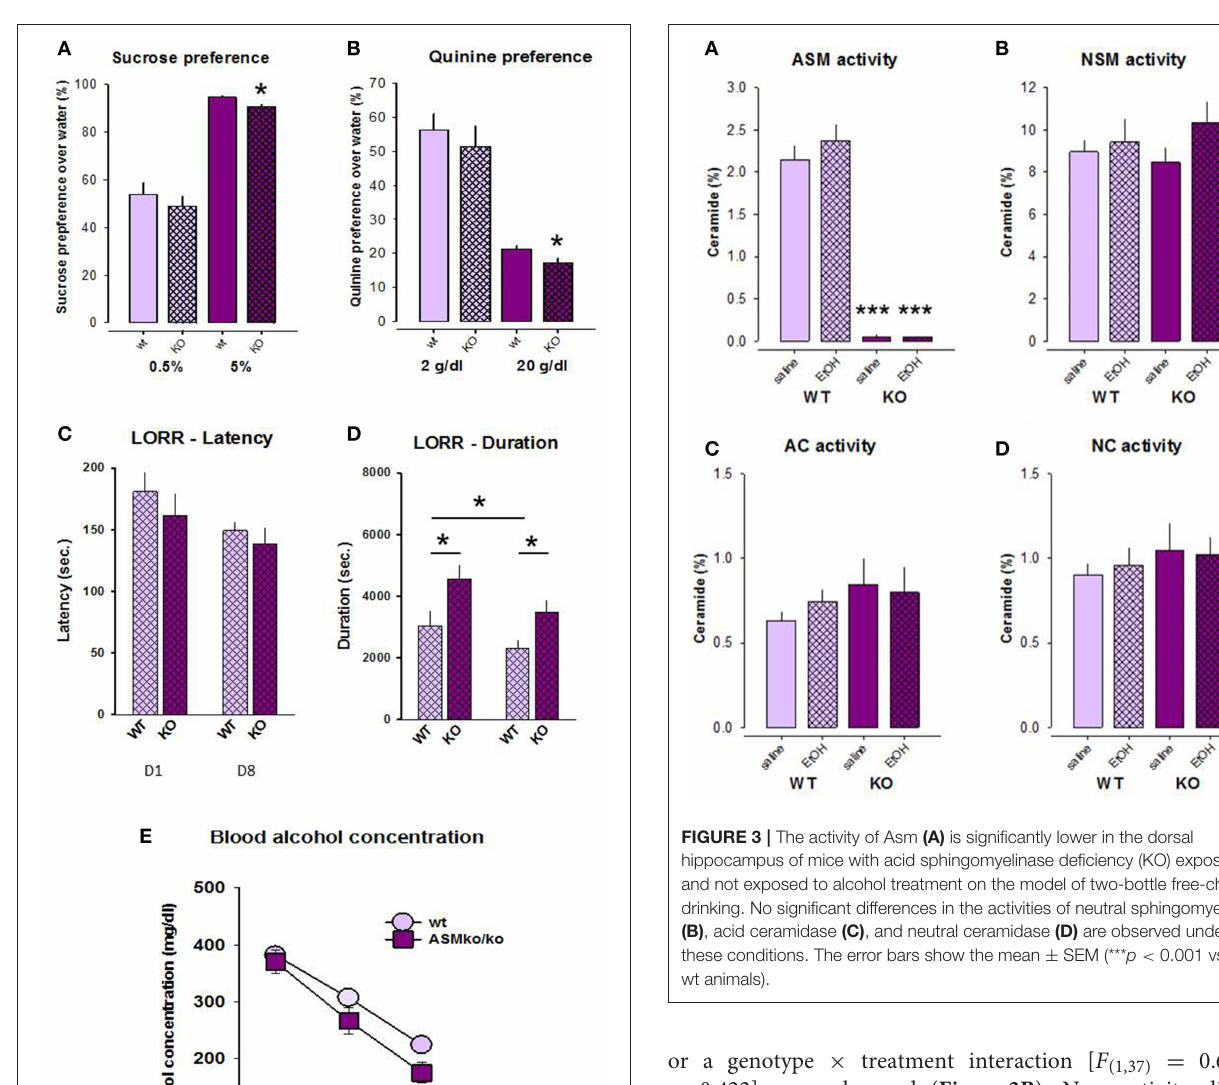
expected, Asm activity was significantly lower in Asm − / − mice drinking both water and alcohol compared to wt mice ( p < 0.001).